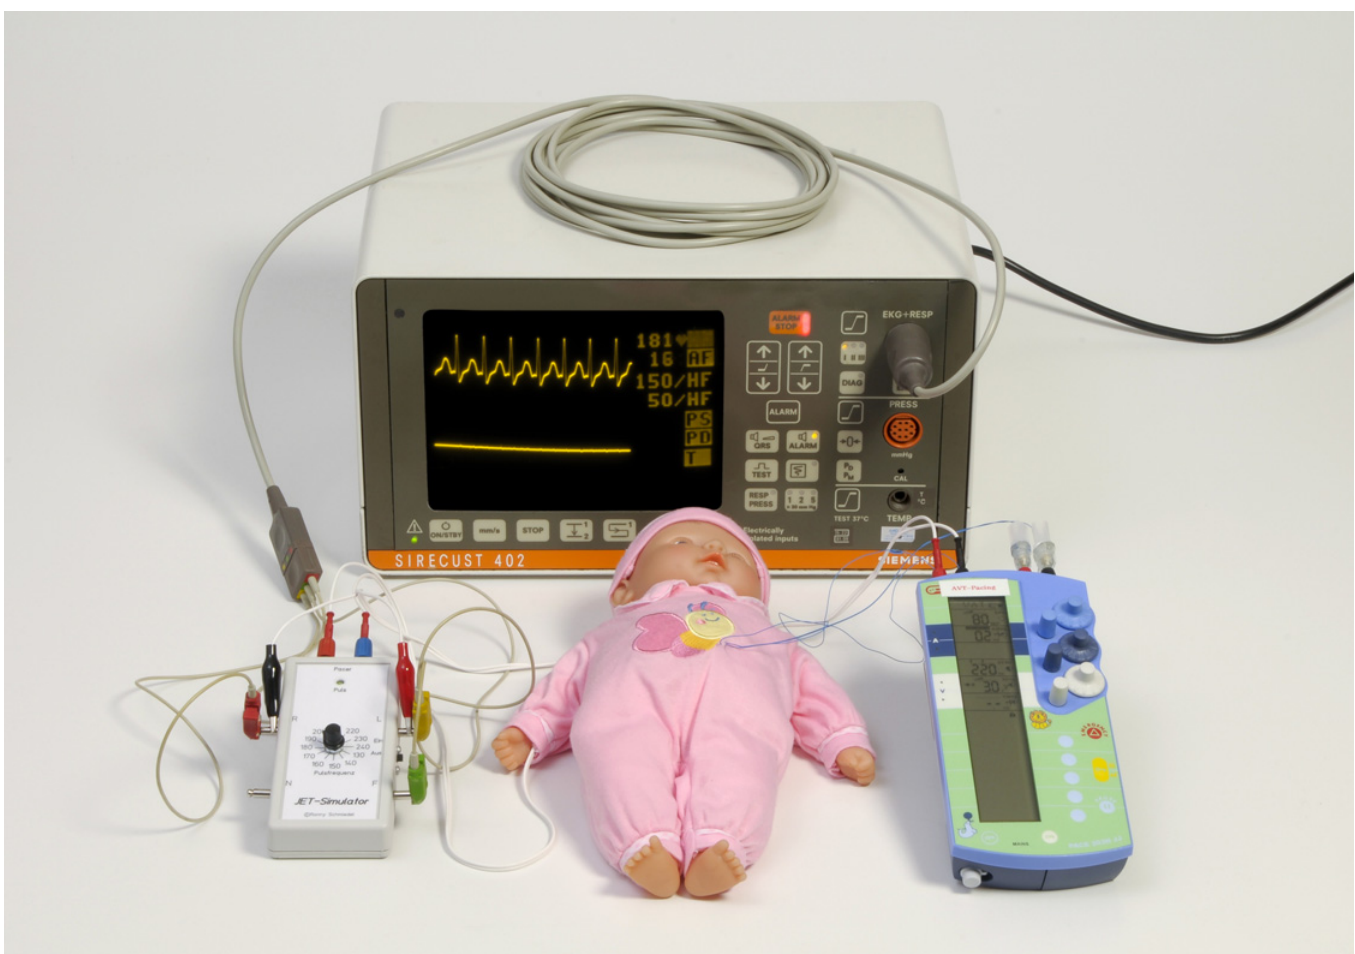
Fig 3. The simulation model. The model is composed of the JET-Simulator, an ECG monitor, a simulation doll, and an external AVT capable pacemaker. The doll is fitted with atrial and ventricular external pacing wires, simulating an infant after cardiac